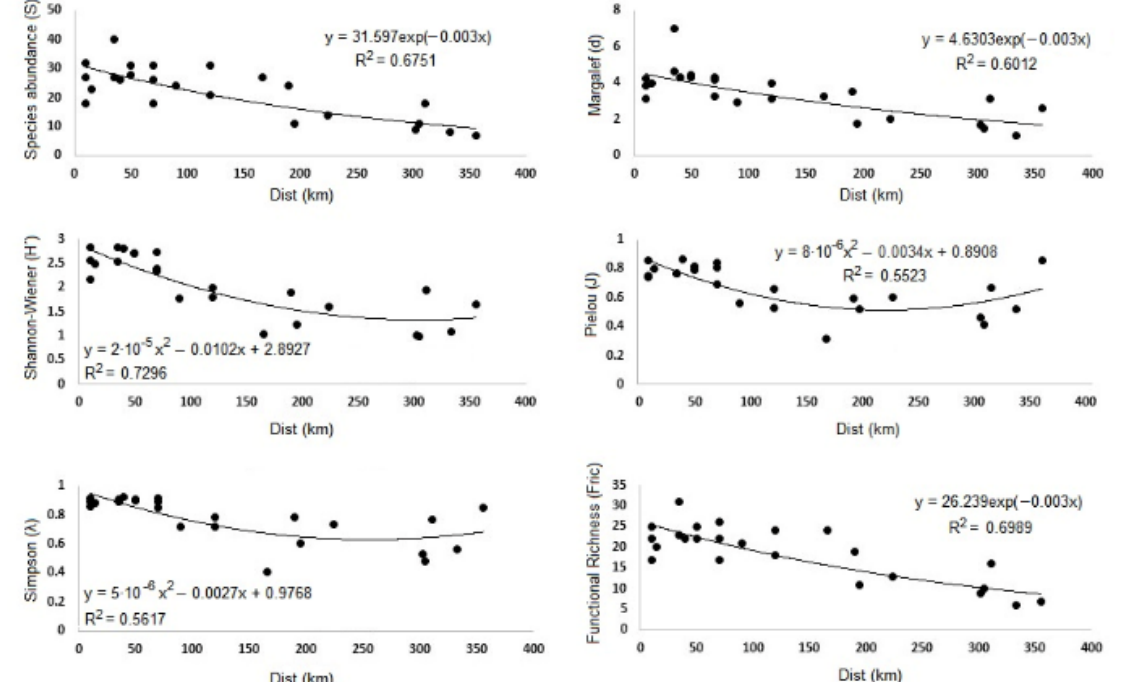
Figure 3. Regression models of distance from the source vs. community indices.